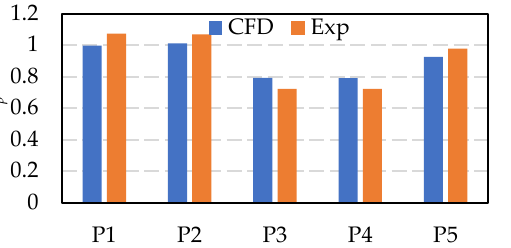
Figure 5. Pressure monitoring point selection.